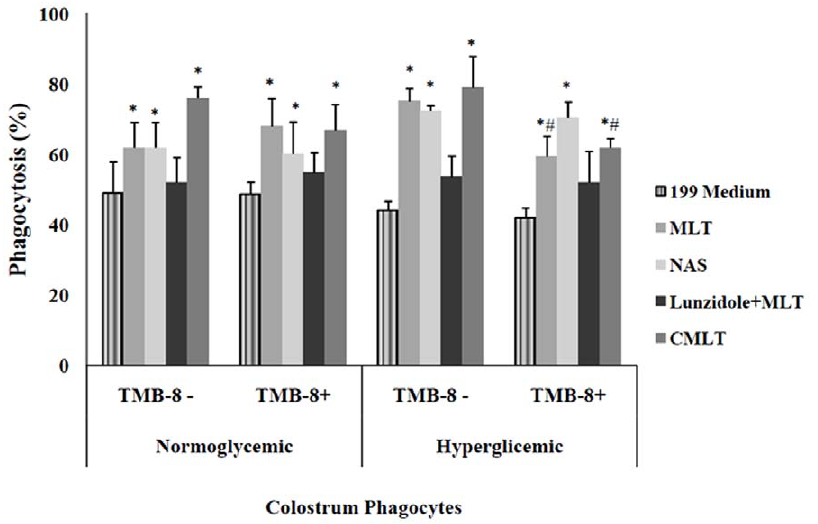
Figure 2. Bacterial phagocytosis by colostral phagocytes (mean ± SD, N=7 in each treatment), determined by the acridine orange method. Phagocytes were pre-treated or not with 8-(Diethylamino) octyl-3,4,5-trimethoxybenzoate hydrochloride (TMB-8) and incubated with enterophatogenic Escherichia coli (EPEC) in the presence of melatonin (MLT), N-acetyl-serotonin (NAS), luzindole or chloromelatonin (CMLT). * indicates differences from the 199 medium (ANOVA, P , 0.05); # indicates differences between TMB-8 use within each treatment and group.